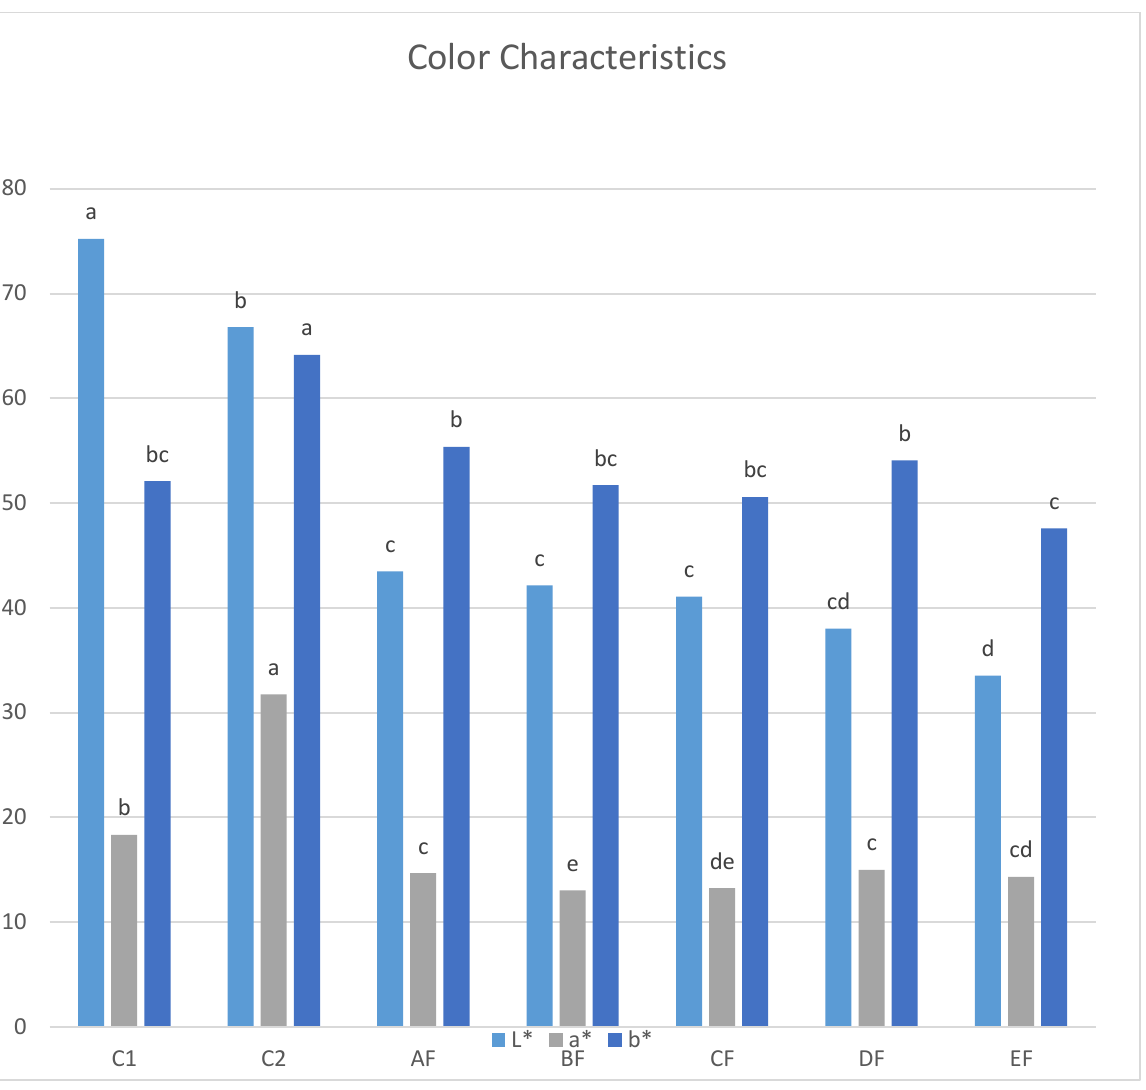
Figure 2. Colour values of gluten-free doughnut with different treatments: AF (15%), BF (30%), CF (45%), DF (60%) and EF (75%) lupin flour: potato starch and corn flour composite, (C1) based on wheat flour; (C2) based on potato starch and corn flour composite. Different letters for different treatments mean they are significantly different ( p ≤ 0.05) by D uncan ’ s multiple range test.